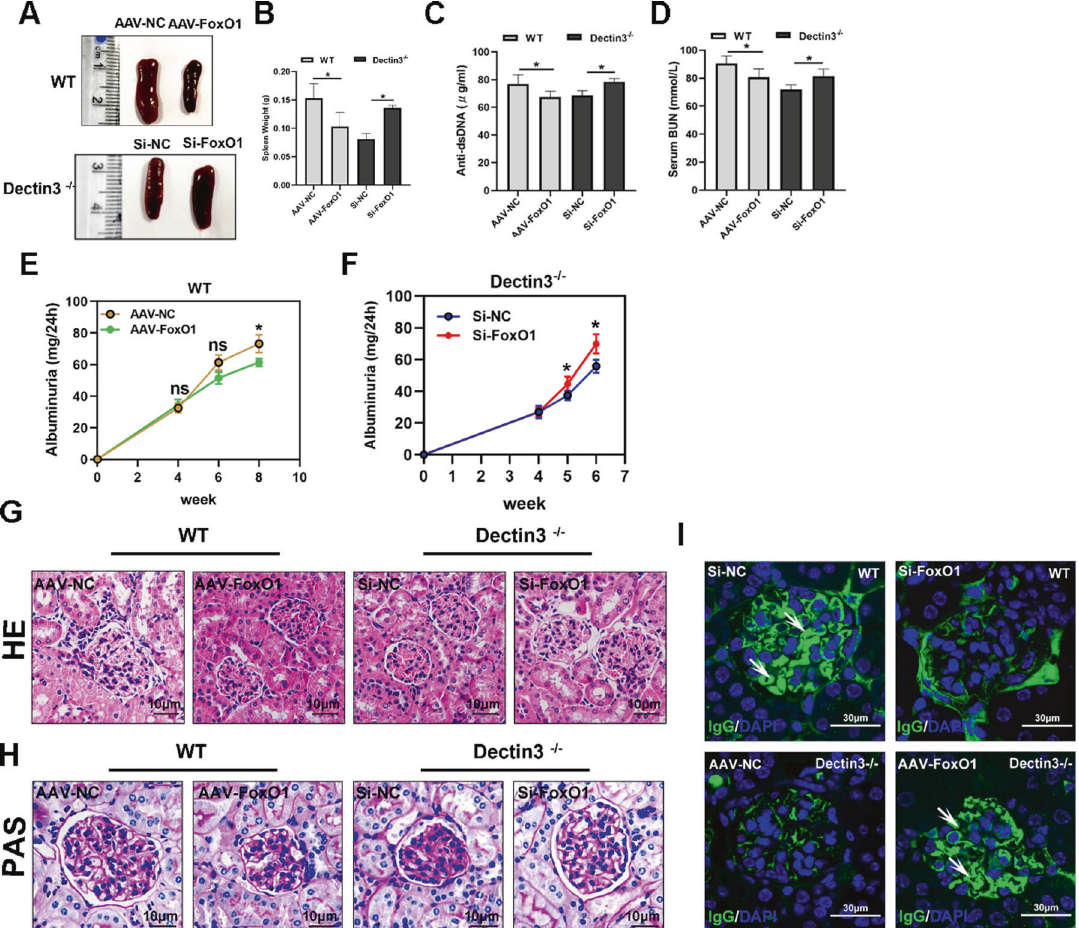
Fig. 5 Silencing of FoxO1 expression in Dectin3-de fi cient mice aggravated the lupus-like disease. A , B Representative photographs of the spleen and spleen weights. C – F ELISA analysis of the serum levels of anti-dsDNA, BUN, and 24-h mouse urine protein. G , H HE and PAS staining of kidney sections (scale bar = 10 μ M). I Amounts of IgG deposits in glomeruli were measured by immuno fl uorescence analysis (scale bar = 30 μ M). Data represent the mean scores ± SEM. * P ≤ 0.05, ** P ≤ 0.01, *** P ≤ 0.001; n = 5 mice per